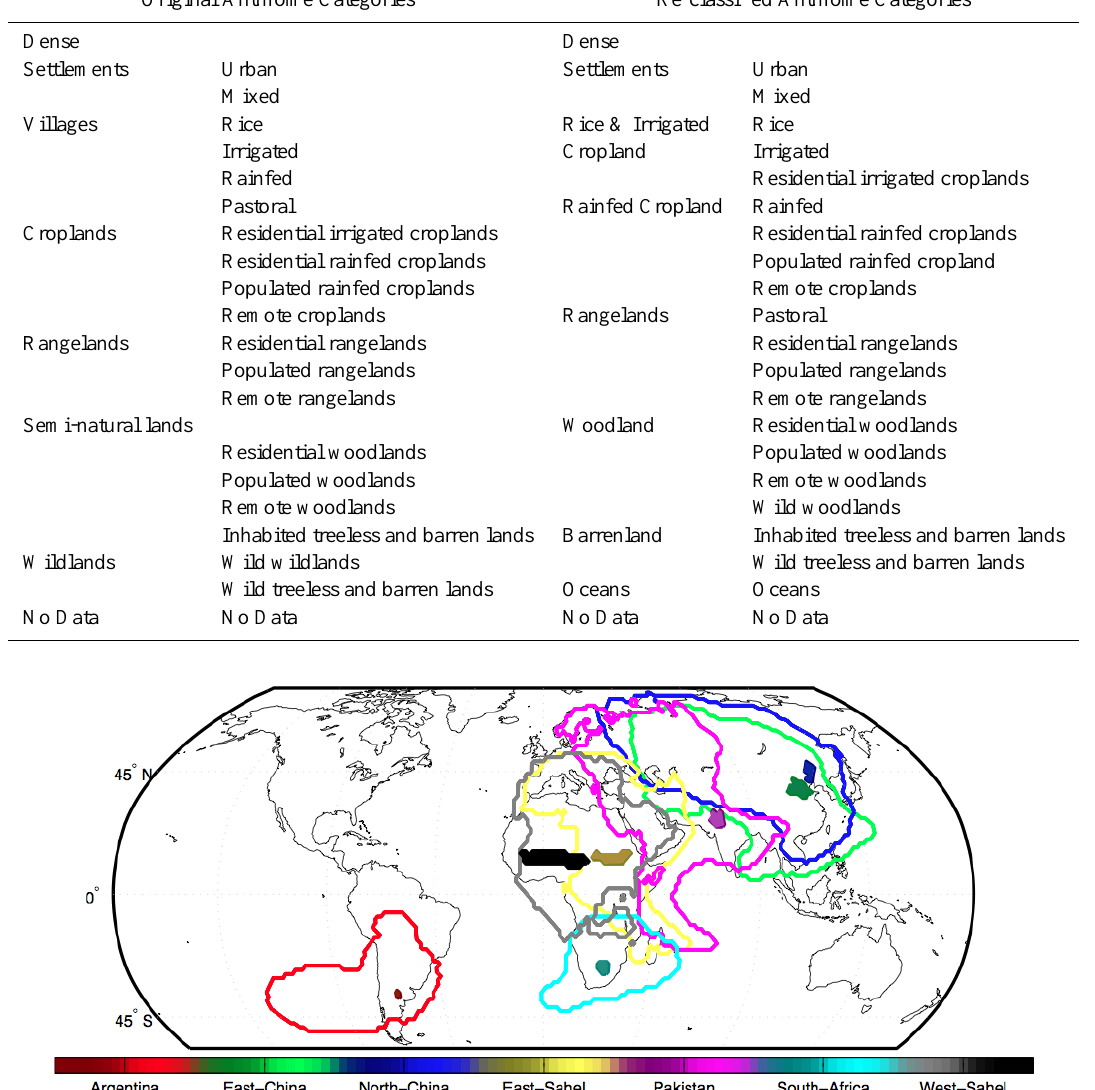
Fig. 4. The relative precipitationsheds (at 70% precipitation contribution) for all seven sink regions in this study. The darker colors indi- cate the sink regions (see Fig. 2) and the lighter colors indicate the precipitationshed borders. The gray border of the West-Sahel region corresponds with the pink border in Fig. 3b. The other colors corresponds to the pink border in Supplement Figs.